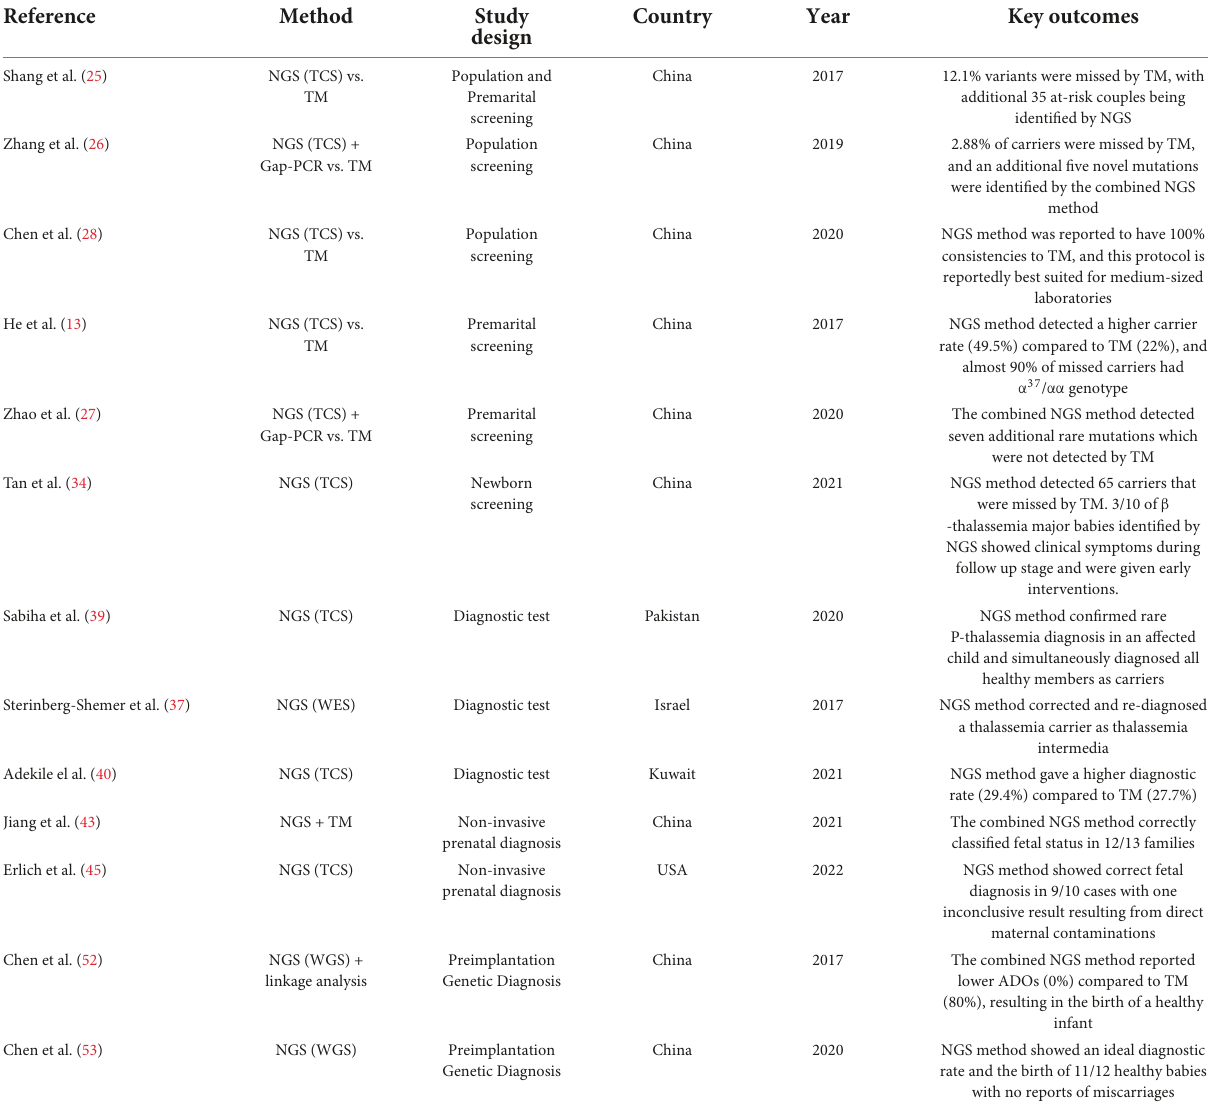
TABLE 1 List of studies using NGS in thalassemia screening and diagnosis from 2017 to